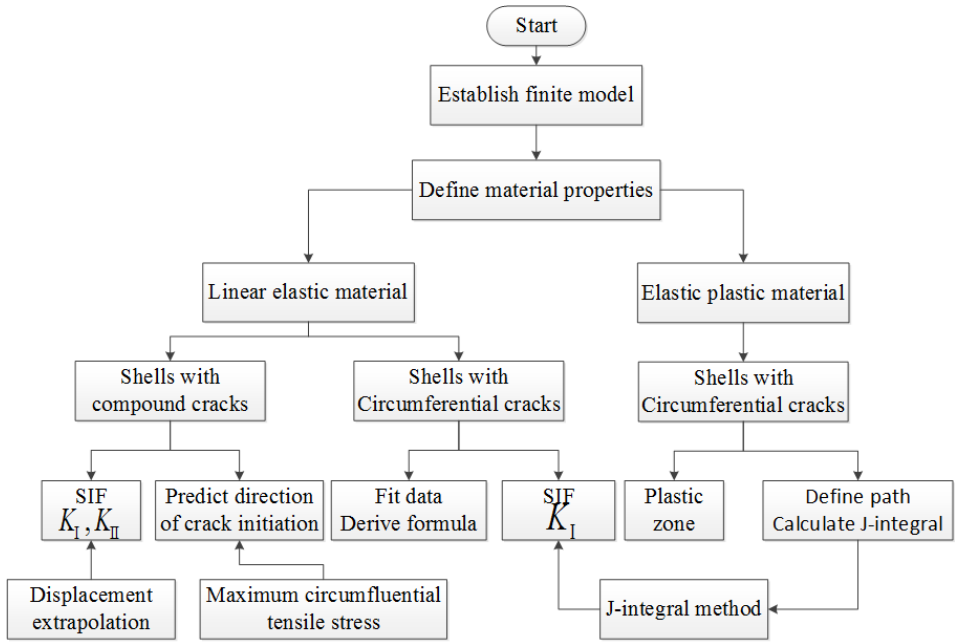
Figure 7. Calculation process of thin-walled cylindrical shells with cracks. For a circular section, is defined as the centre angle corresponding to the half length of the crack. So, the crack length is determined by changing the central angle . The value range of is 0° – 45°, and the corresponding crack length b R = . Here, the